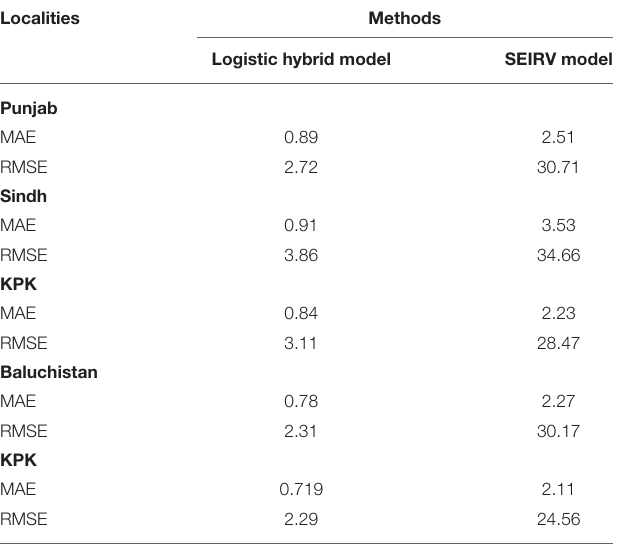
TABLE 5 | The results of all provinces of population size.